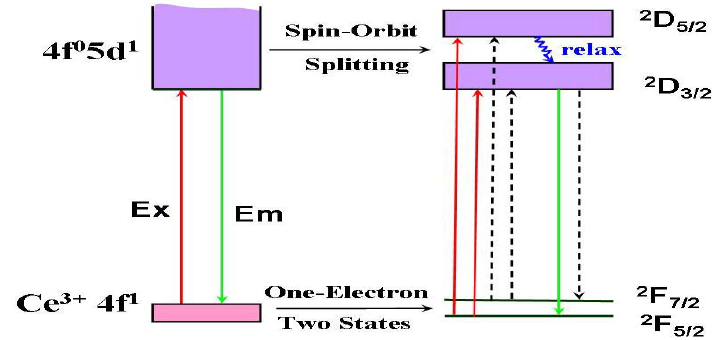
Figure 4. Energy-level diagram of YAG:Ce 3+ and its excitation (EX) and emission (Em) process. The dashed lines denote the potential process.